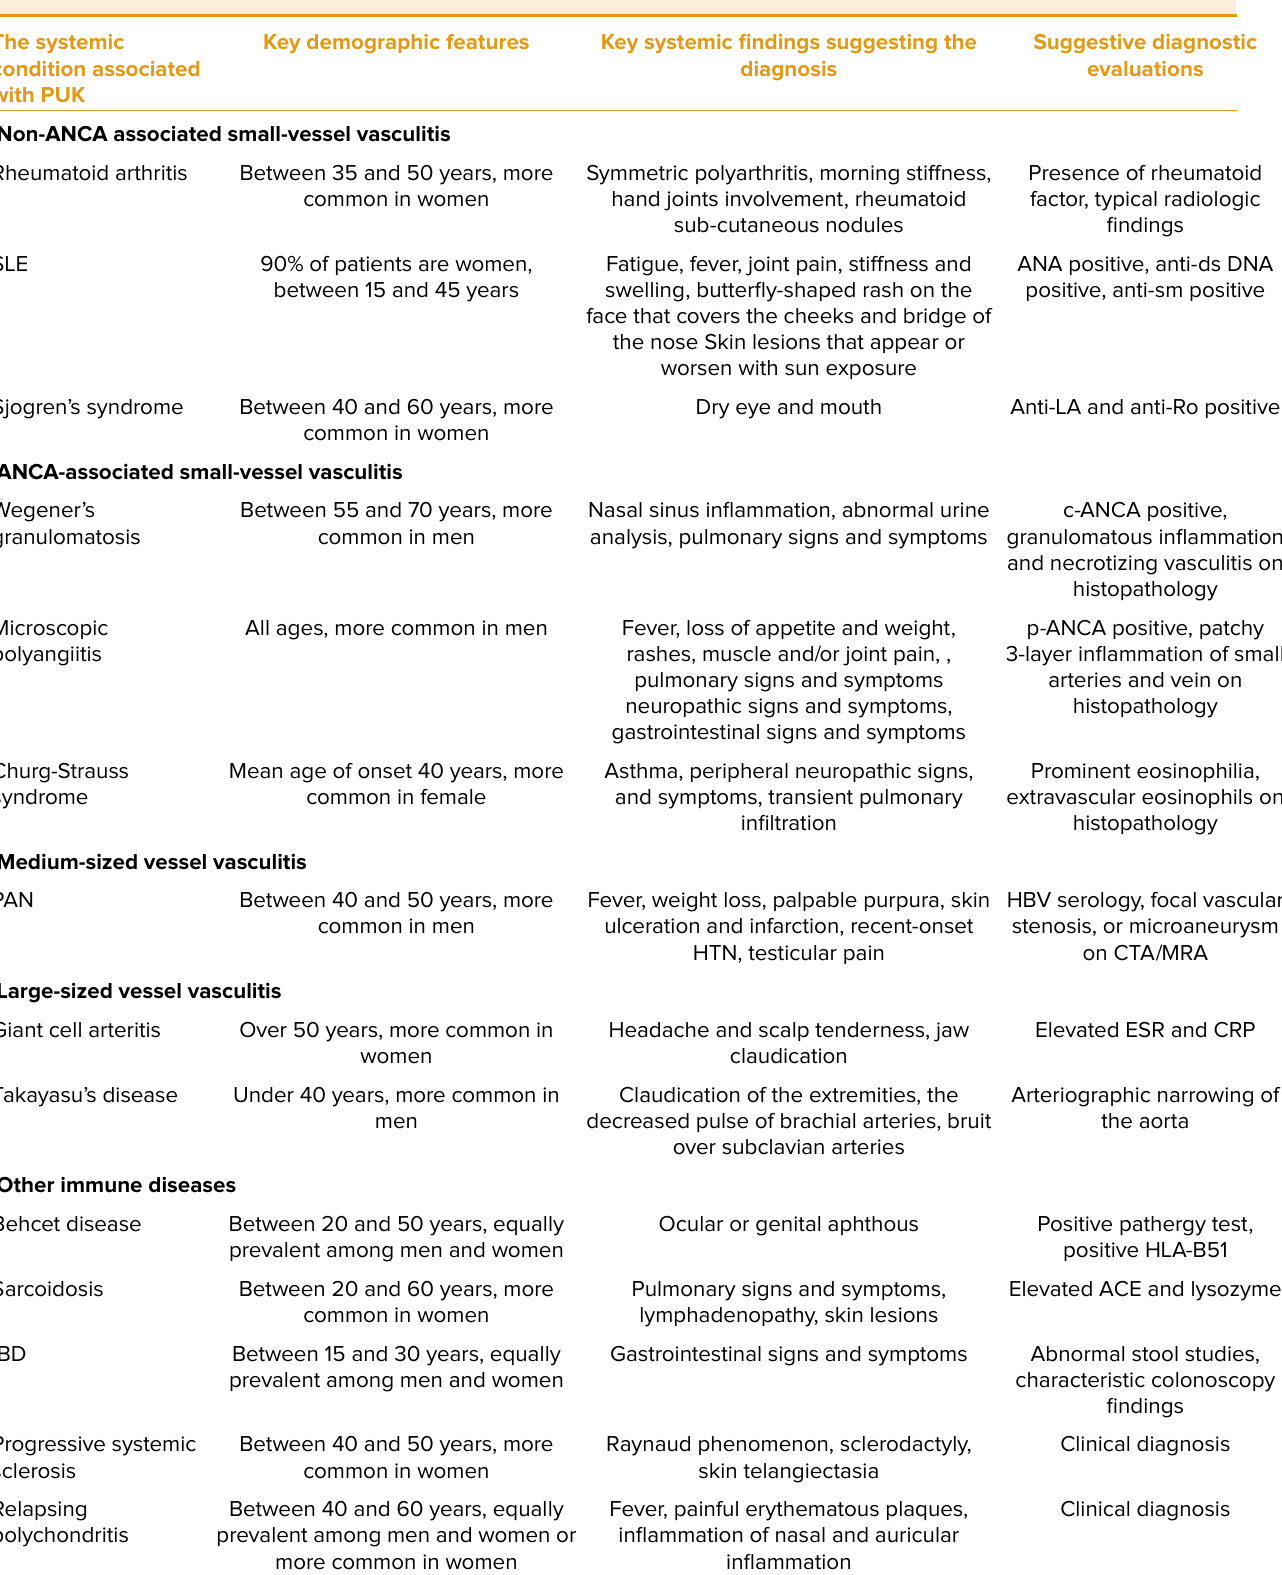
Table 1. Some systemic noninfectious diseases associated with PUK, and their key findings necessary for an ophthalmologist to